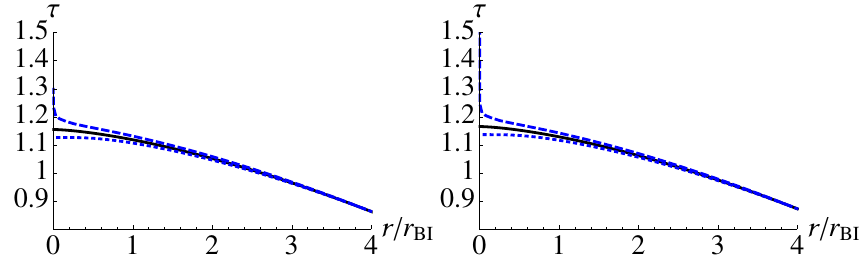
Figure 4. The infalling proper time τ ( r ) for ε = 1 ( left ) and ε = 0 ( right ) is shown as a function of r / r BI . The dashed, dotted and the solid curves correspond to δ = 0.01, δ = − 0.01 and δ = 0 (GR) at x i = 10,